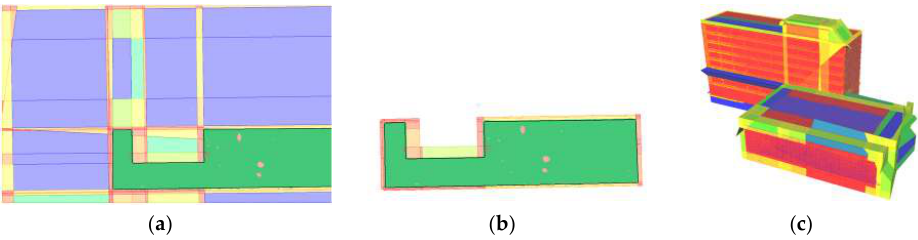
Figure 12. Invalid face elimination in a single plane. (a) The original candidate faces of a planar primitive generated by intersection. (b) The valid candidate faces after elimination. The black frame delineates the merged boundary of the original plane and the polygon colors are rendered by the confidence of each candidate face in PolyFit from red (high) to blue (low). (c) The remaining plane candidates, from which the planes of the final polyhedral models are selected (refer to Dublin2 in Table 1 for the original points and the final model).